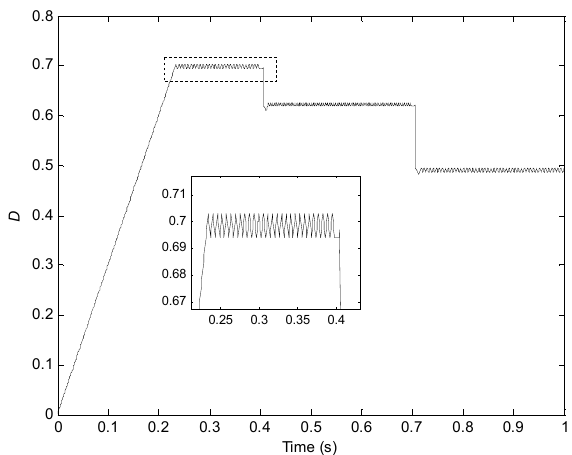
Figure 25. Duty cycle curve in first simulation.